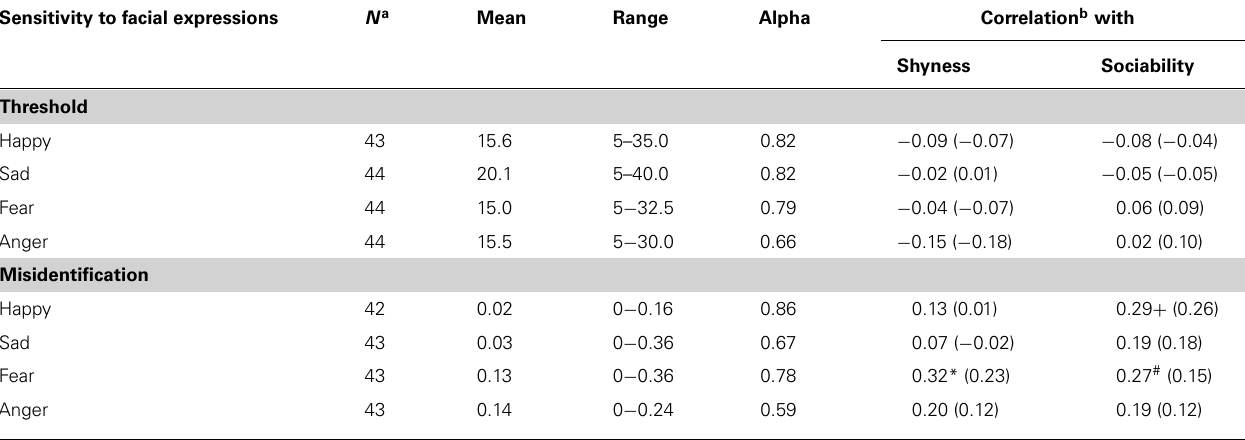
Table 2 | Descriptive statistics of expression sensitivity measures and their correlation with temperament in Experiment 2. Sensitivity to facial